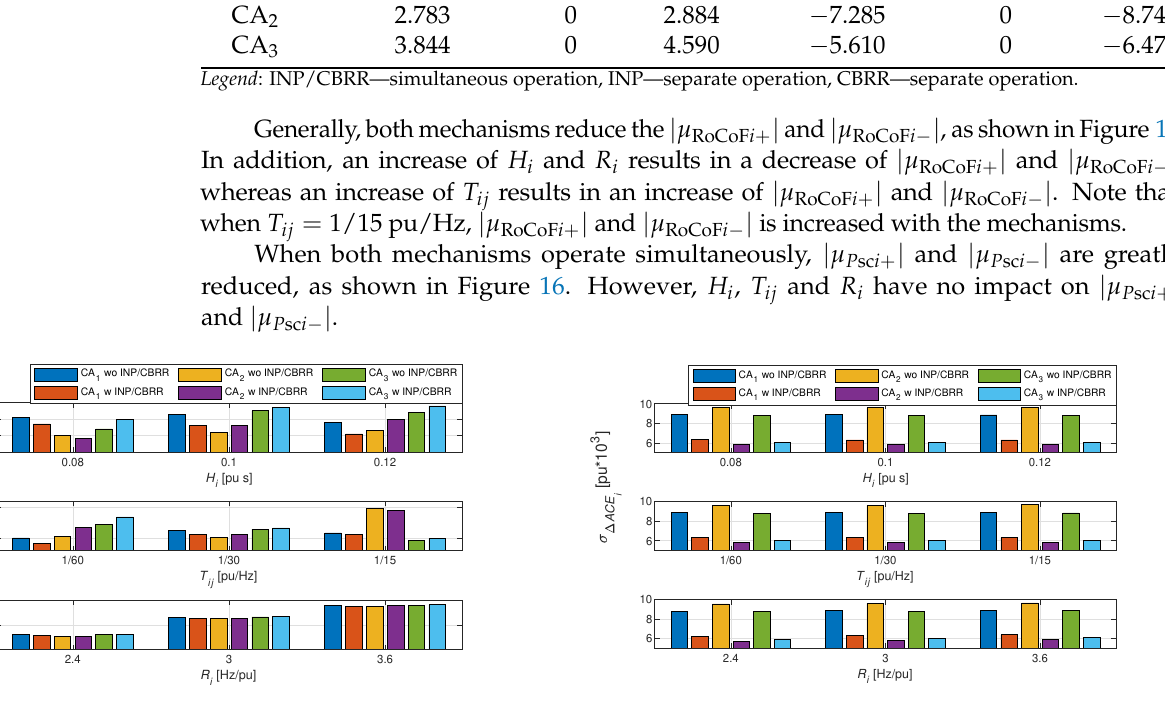
( left ) and average values of σ ACE i